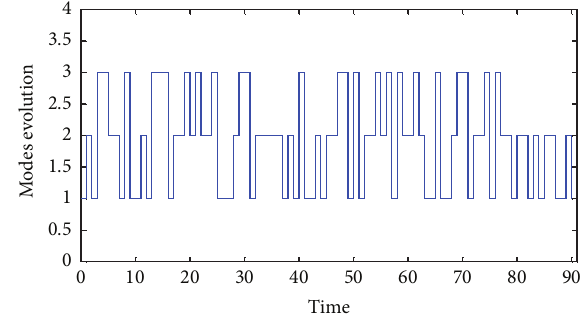
Figure 4: Modes evolution in Example